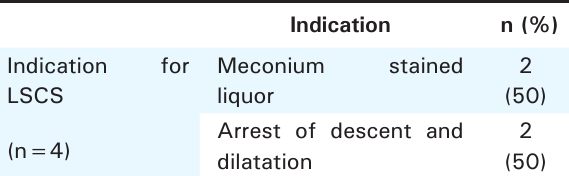
Table 4. Showing the indications for LSCS.